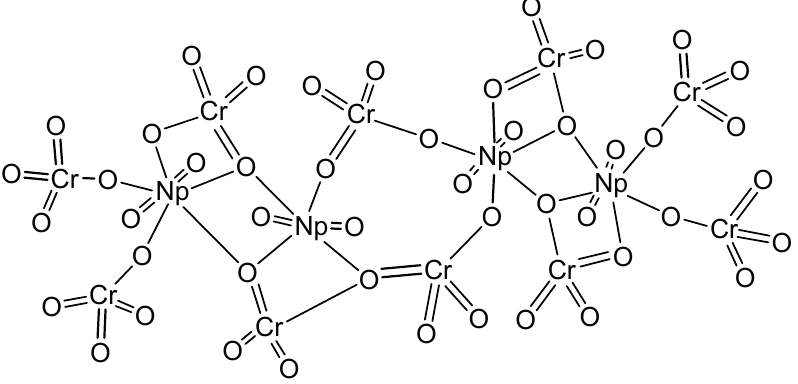
H N NH 2 2 3 n − in the structure of Figure 8. Anionic chain [CpO (CrO ) ] 2 4 2 n ) ] [NpO (CrO ) ](H O). Thermal vibrational ellipsoids are shown with the [C(NH 2 3 3 2 4 2 2 50%